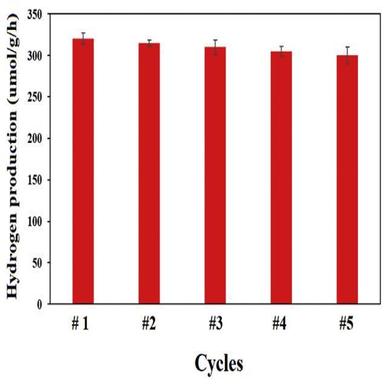
Hydrogen production of recycled 6VeCuWO4.